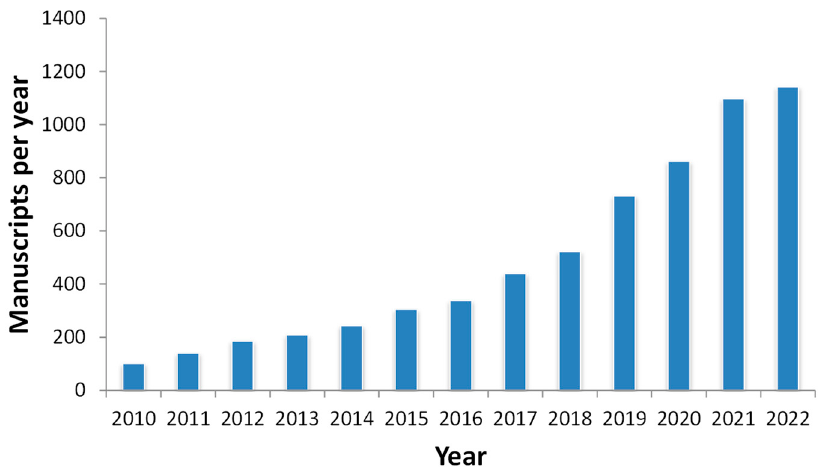
Figure 9. Bibliographic citations since 2010. The number of references was taken from WoS and Scopus. The keywords used in the study were agriculture plus encapsulation.